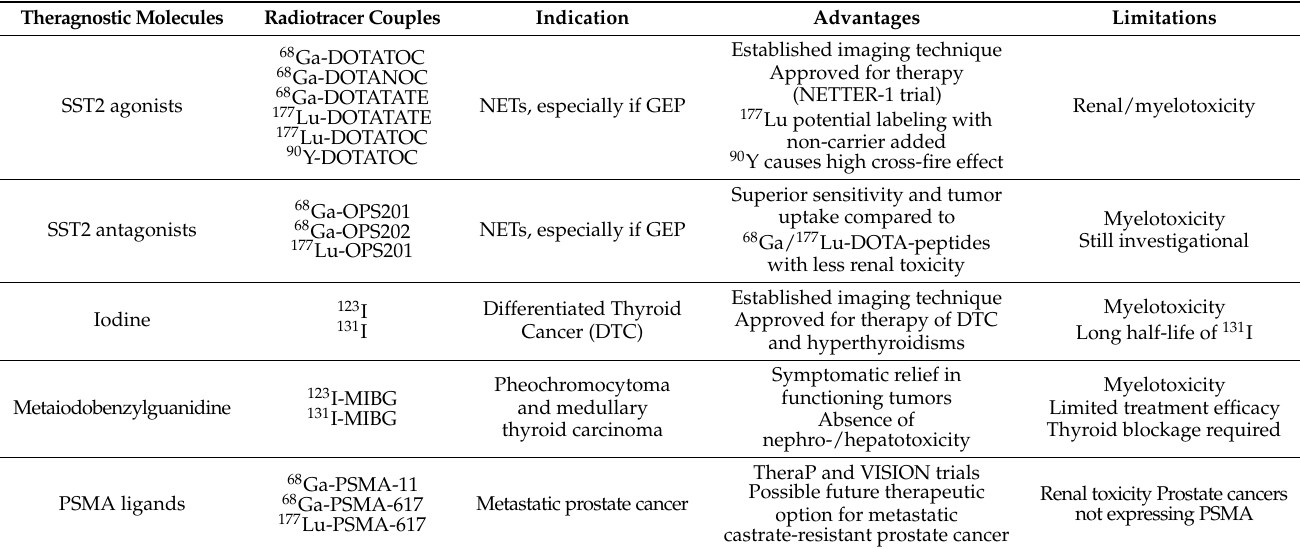
Table 1. Principal theragnostic couples currently in use and